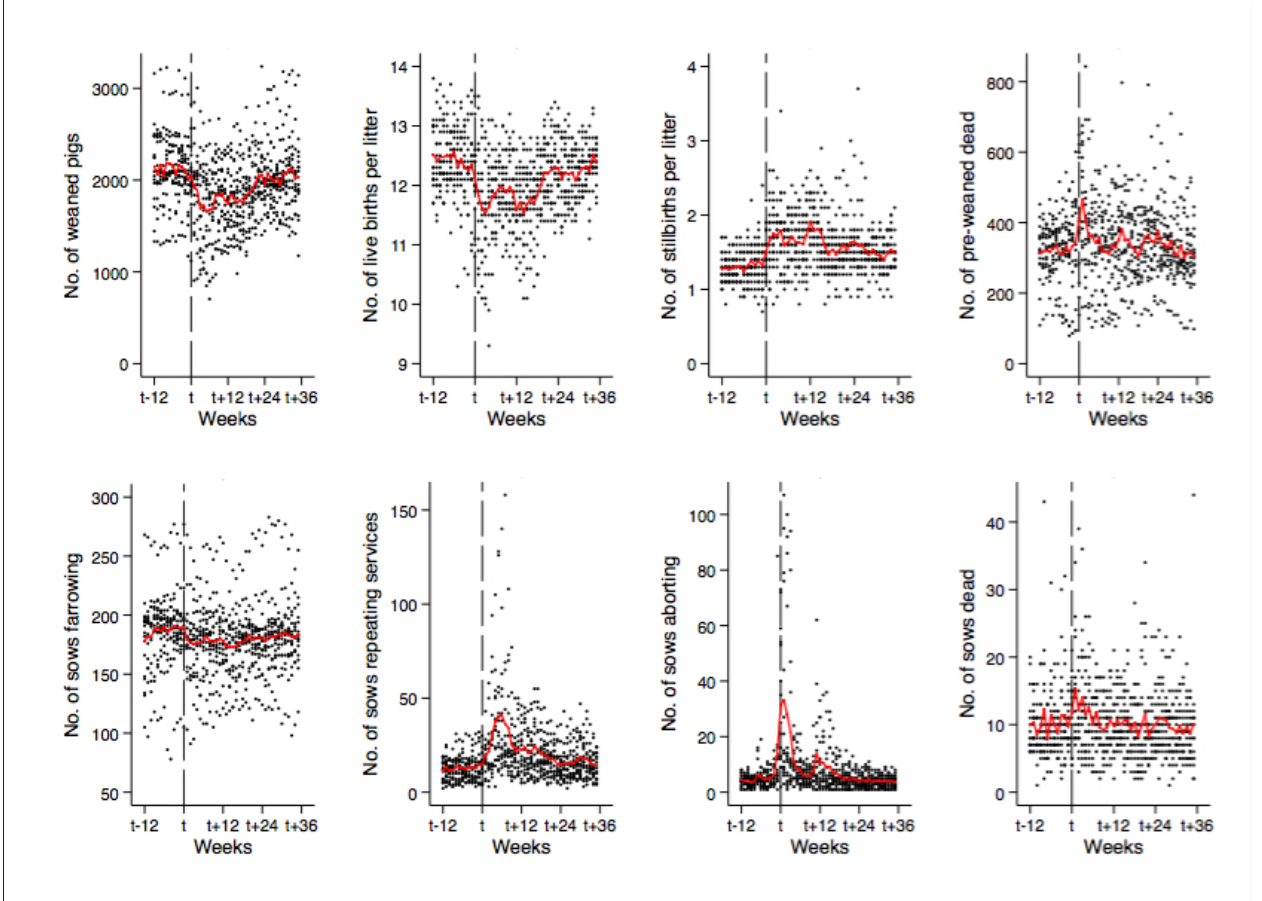
FigUre 2 | Weekly average (red lines) and observed (dots) number of weaned pigs and the seven additional performance indicators during pre- and post- outbreak